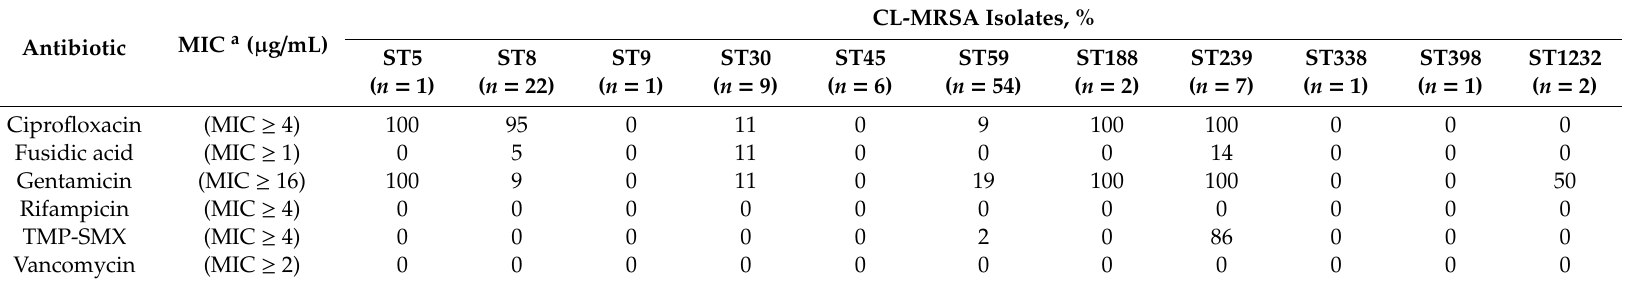
Table 4. The relationship between the antibiotic resistance and MLST genotypes for CL-MRSA isolates ( n = 106).